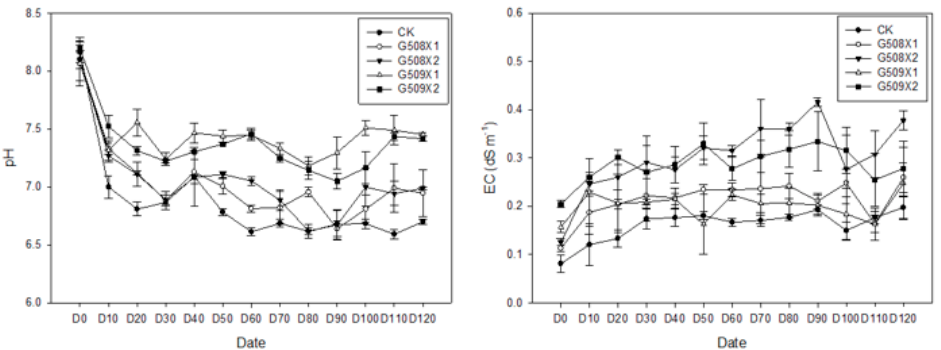
Figure 6. Changes in pH and EC in soils during the incubation experiment under different treatments ( n = 3).